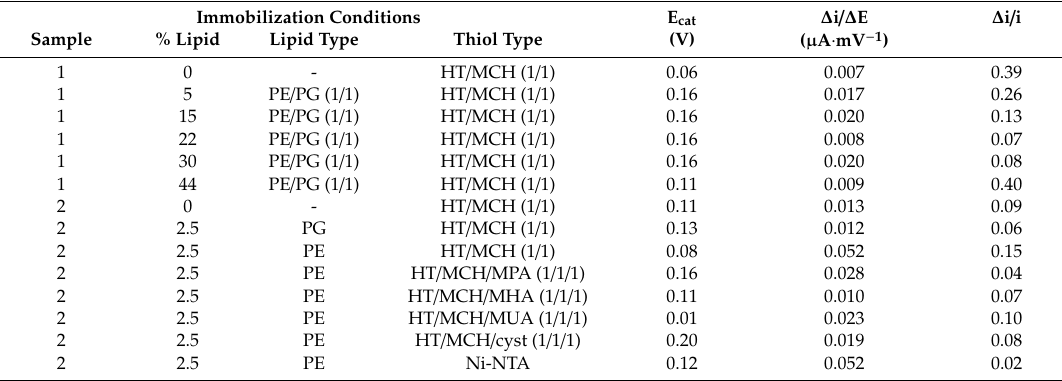
Table 1. Half wave catalytic potential (E cat ), slope of the limiting current (  i/E) and variability of the limiting current value between two consecutive scans separated by 10 min (i/i), obtained for the different immobilization conditions tested in this study. Standard error of measurements (SEMs) are 0.02 V for E cat , 0.003 A·mV −1 for